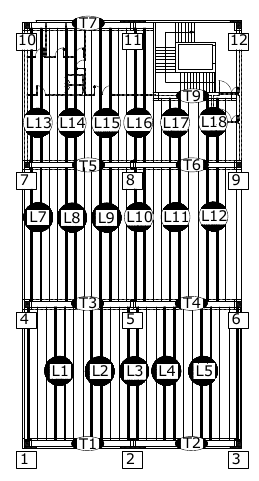
Figure 16: Structural elements